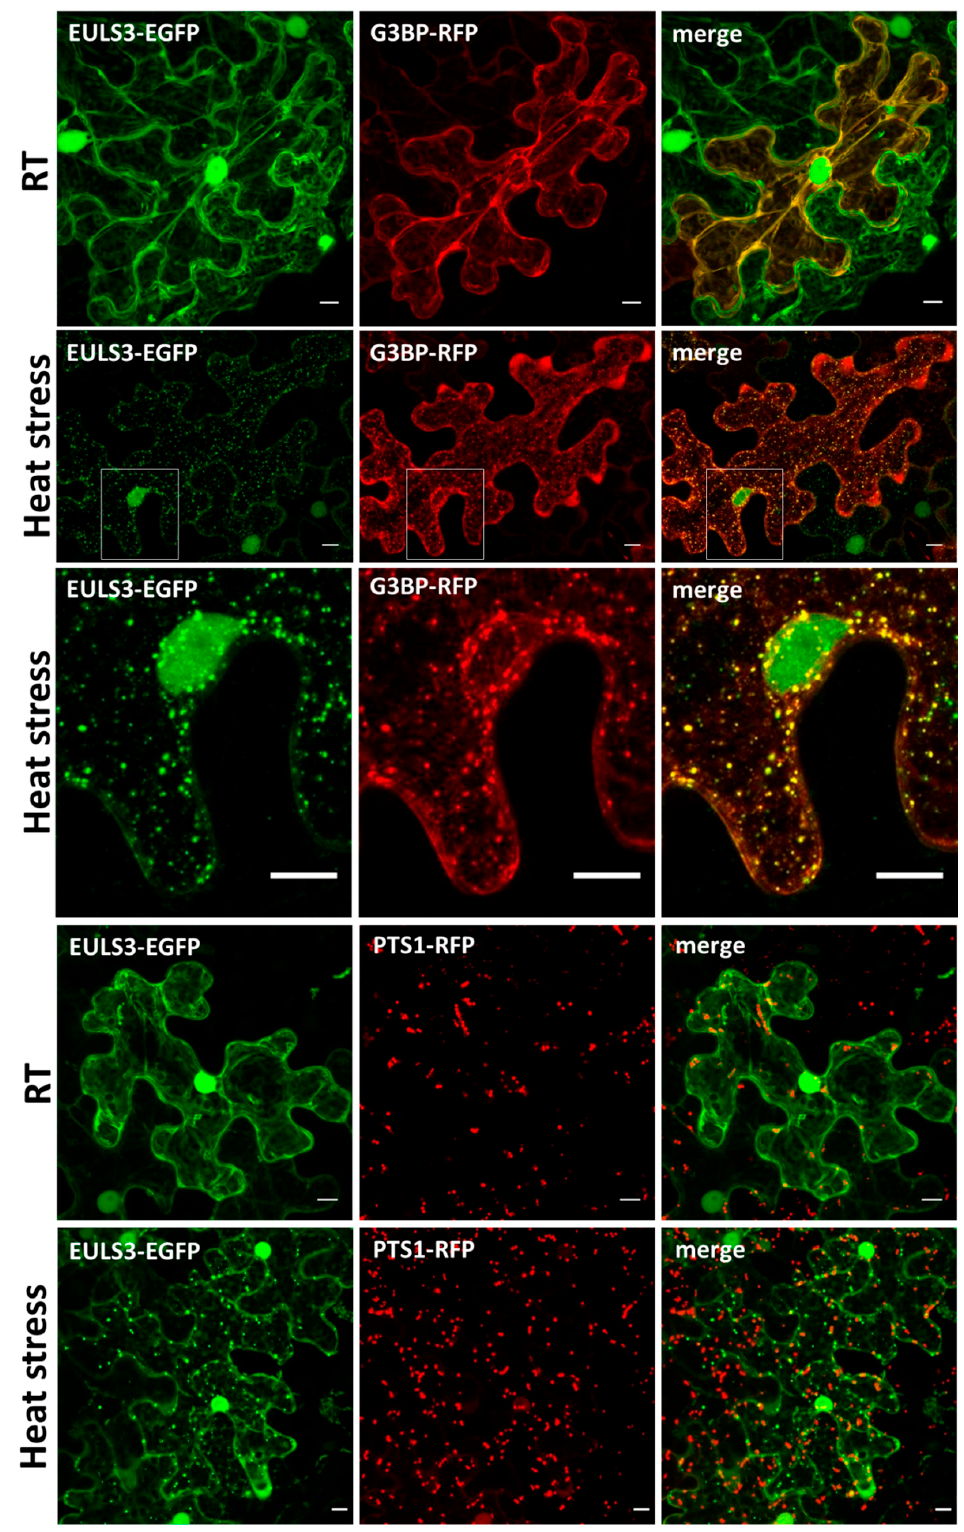
Figure 2. Colocalization of ArathEULS3-EGFP with the G3BP-RFP stress granules marker and the PTS1-RFP peroxisome marker. Confocal images represent epidermal cells of Nicotiana benthamiana leaves after transient coexpression of ArathEULS3-EGFP with G3BP-RFP at room temperature (RT) and after 45 min of heat treatment at 37 °C. All images show a projection of fluorescent images acquired along the z-axis. Scale bars represent 10 µm.